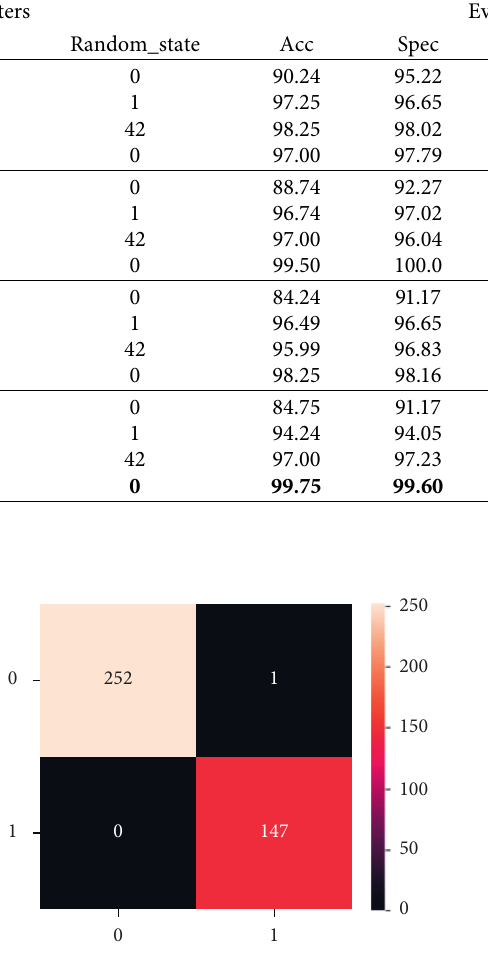
Figure 7: Confusion